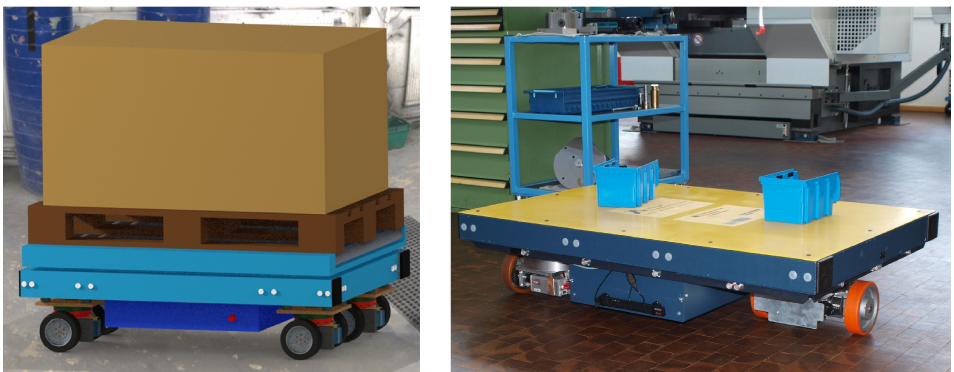
Figure 12. Redundant ultrasonic sensors at the side of the